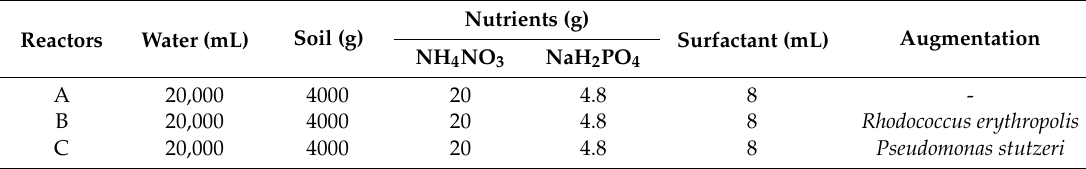
Table 1. Design of bioaugmentation bioslurry